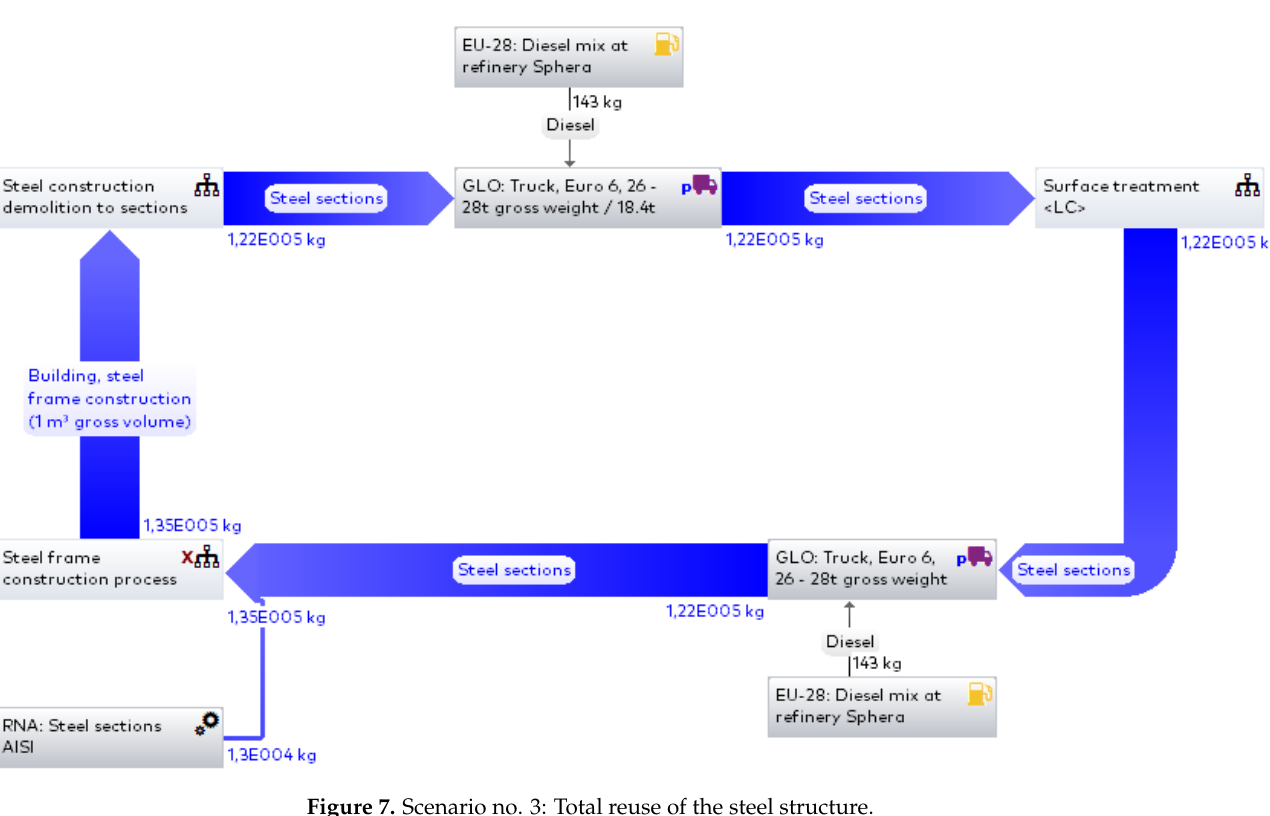
Figure 7. Scenario no. 3: Total reuse of the steel structure.